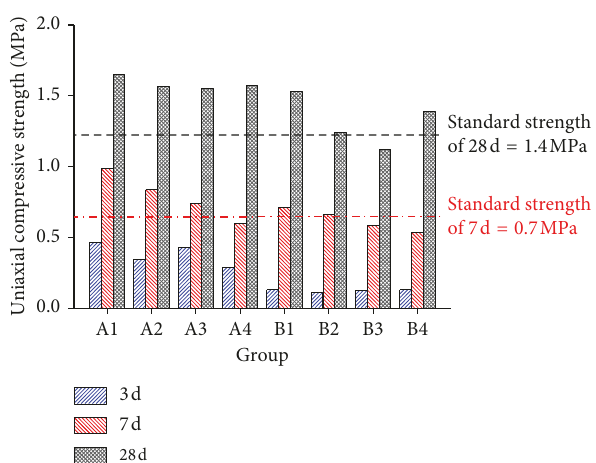
Figure 7: Uniaxial compressive strength of each group of speci- mens at the curing times of 3 d, 7d, and 28d (according to the mine information 7d and 28 d compressive strengths need to reach 0.7MPa and 1.4MPa, respectively. A5 and B5 groups are not analyzed for compressive